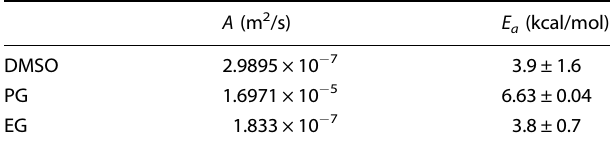
Table 3. Coef fi cients for use in calculating the diffusion coef fi cient of each cryoprotectant in porcine cartilage (Eq. 2) 28 .